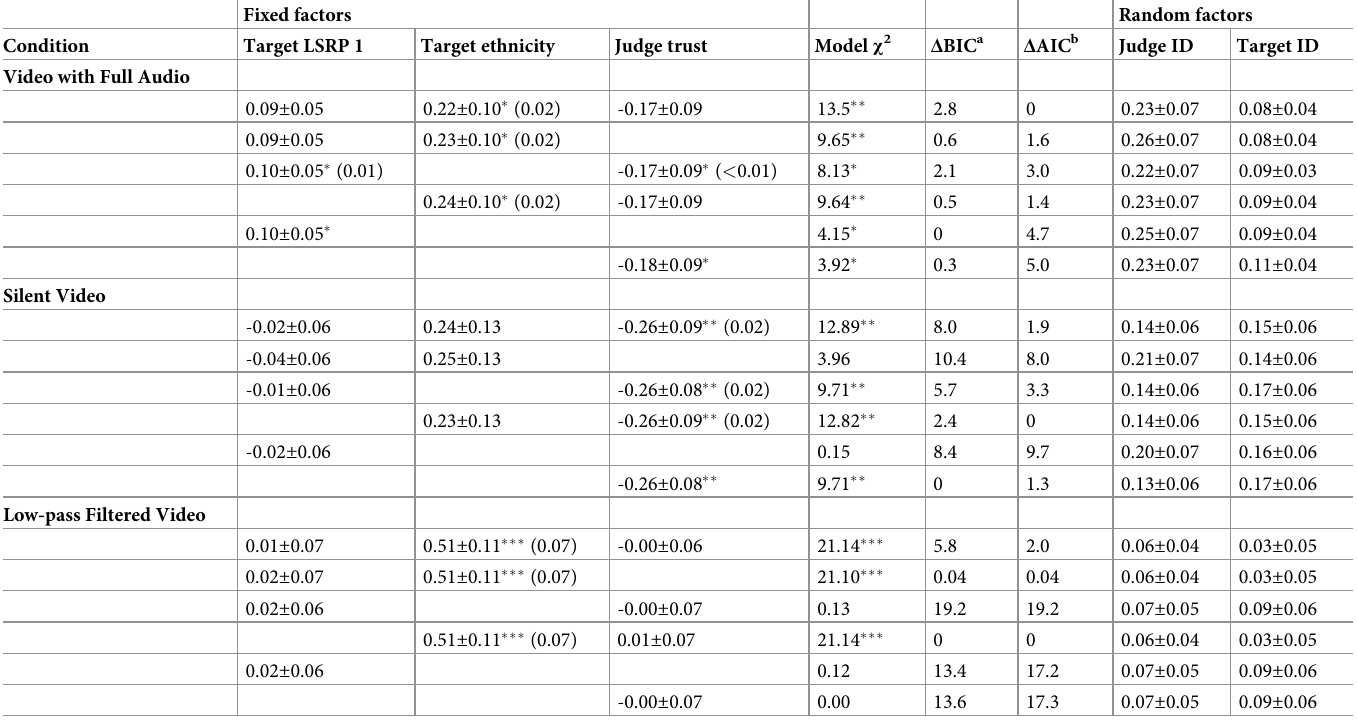
Table 4. Multilevel mixed regression models predicting Levenson other-report primary psychopathy judgments (LORP F1). Fixed